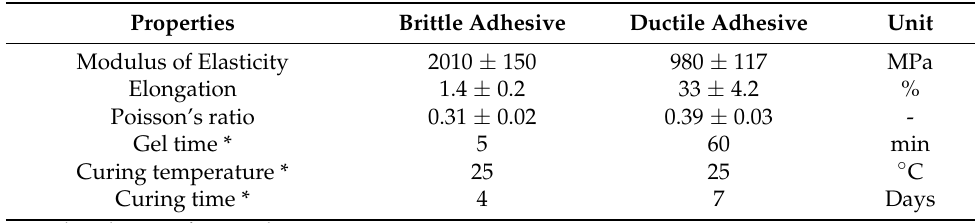
Table 2. Properties of the considered epoxy adhesives